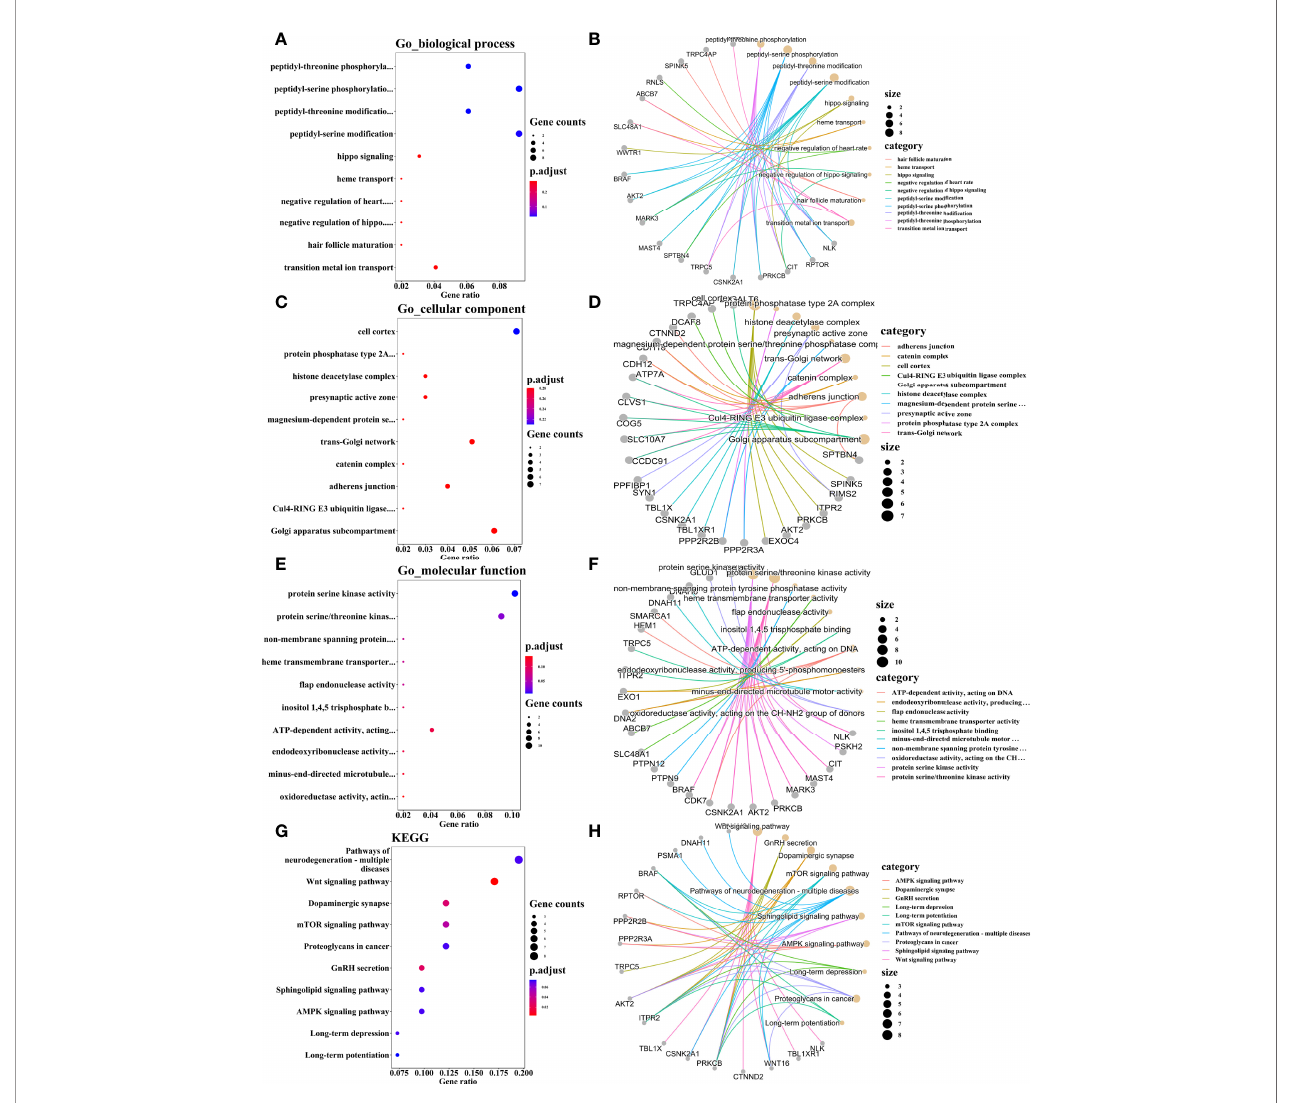
FIGURE 4 | GO and KEGG pathway enrichment analyses of hnRNP E1 related genes. Note: BP, biological process. CC, cellular components. MF, molecular function. GO, Gene Ontology. KEGG, Kyoto Encyclopedia of Genes and Genomes.The top 10 signi fi cant BP (A) , CC (C) , MF (E) , and KEGG pathways (G) . Construction of the enrichment BP_genes network (B) , CC_genes network (D) , MF_genes network (F) , and pathways_genes network (H) . (A, C, E, G) The x axis re fl ects gene ratio, and the y axis represents the KEGG and GO terms. The node size represents the gene count. The node colors represent adjusted P values. (B, D, F, H) The size of the circle indicates the number of enriched genes. Lines represent linkages of genes and enriched